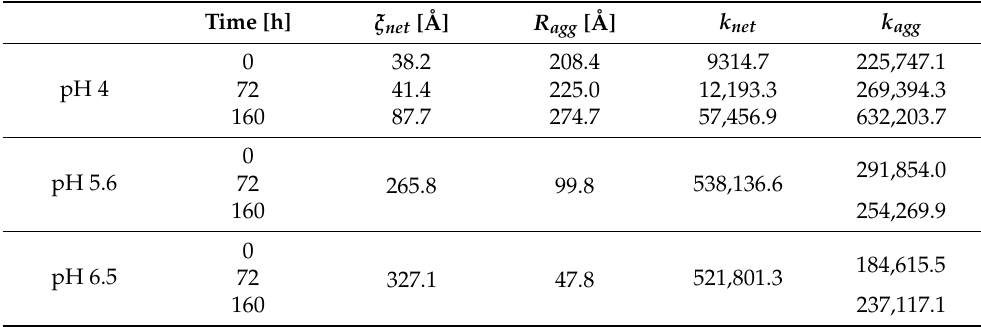
Table 1. Parameters derived from fitting the scattering curves of hydrogels at different pH values and curing